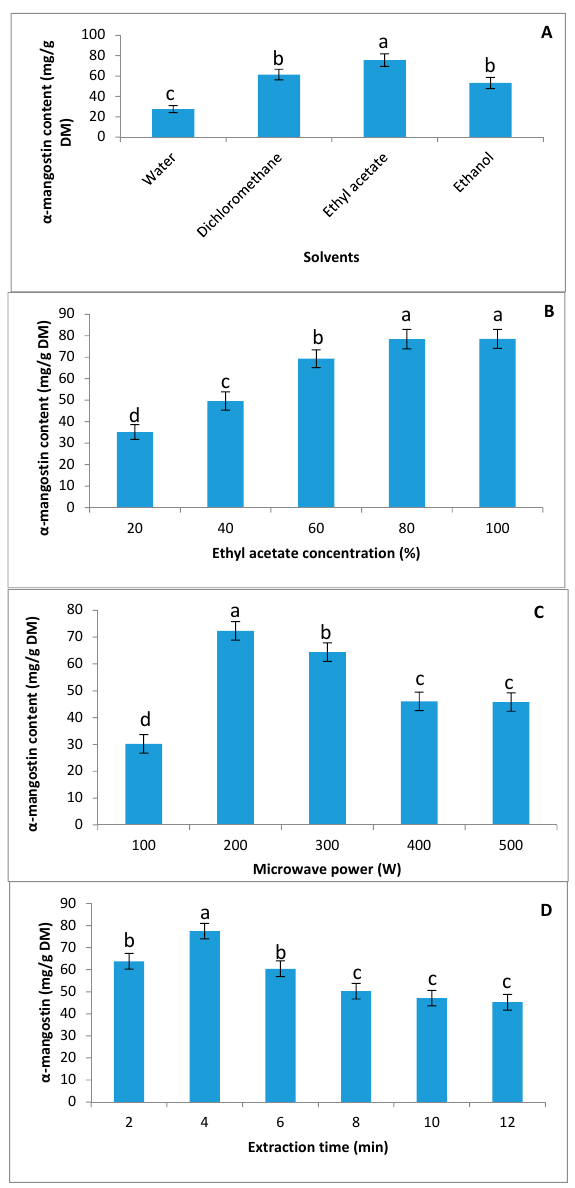
Figure 1. The effect of various solvents, the concentration of solvent, and microwave power on α -mangostin content in the extraction process. ( A ) Effect of various solvents on the extraction yield of α -mangostin; ( B ) effect of ethyl acetate concentration on the extraction yield of α -mangostin; ( C ) effect of microwave power on the extraction yield of α -mangostin; ( D ) effect of various extraction times on the extraction yield of α -mangostin. Different superscript lower-case letters (a,b,c,d) indicate significant differences at p < 0.05 (Duncan’s test).